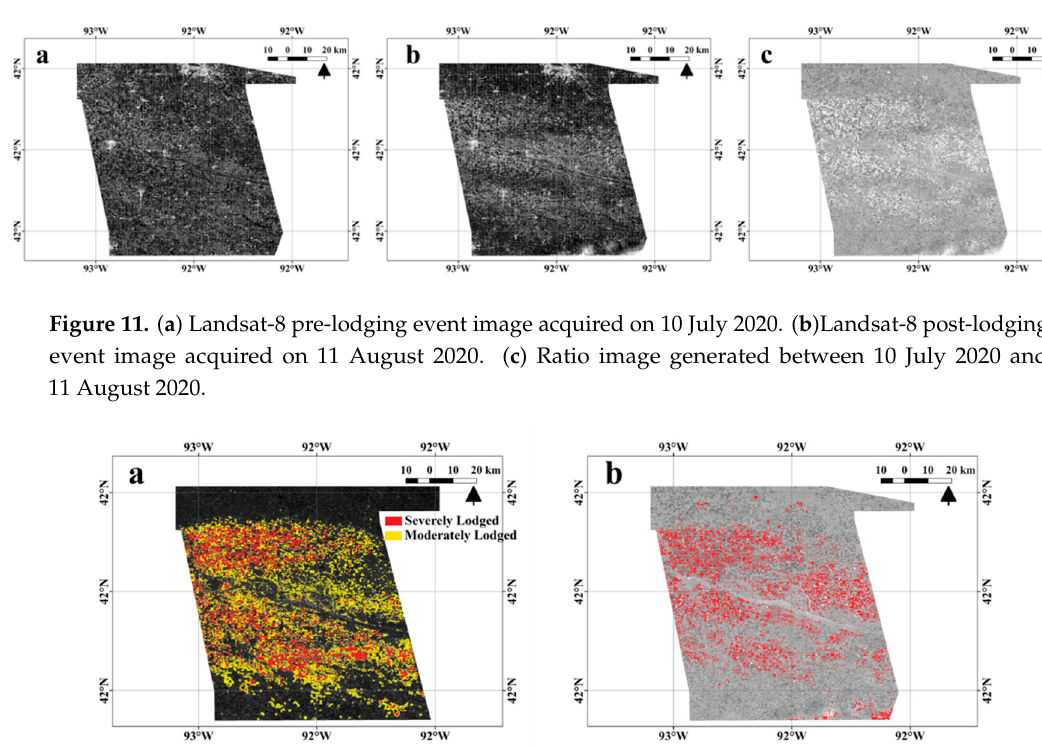
Figure 10. Location of field observations for ( a ) all the eight points and ( b ) a zoomed location for three points. ( c ) Photo for one of the field observations in “b”.